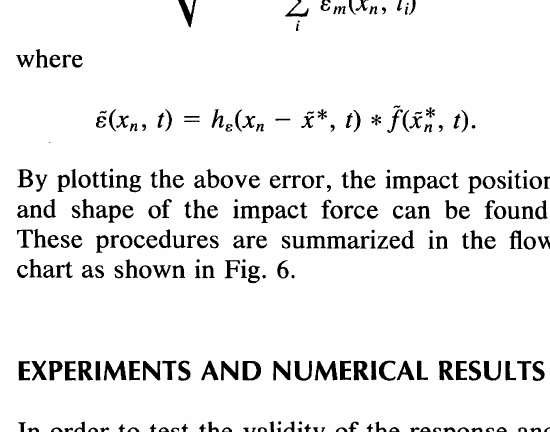
FIGURE 6 Flow chart of the simulation for an arbi trary impact.